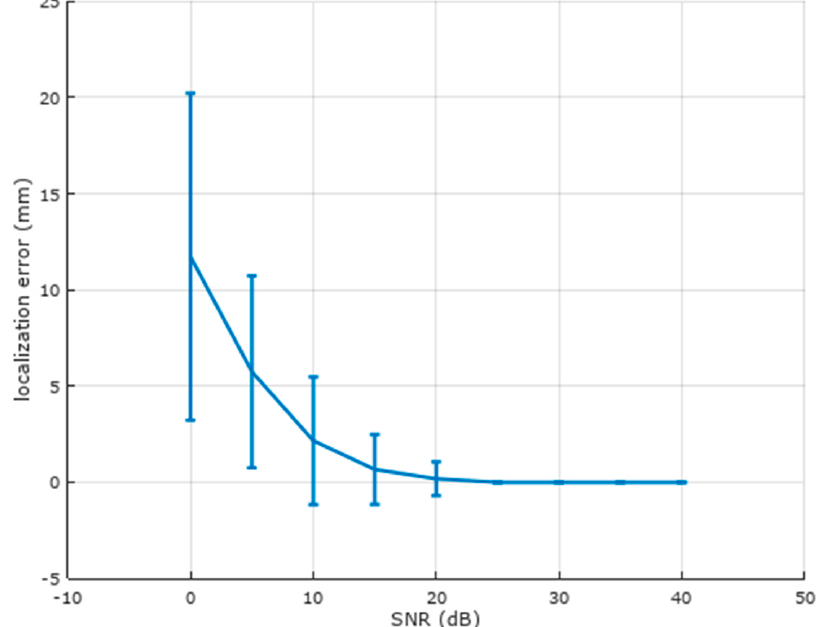
Figure 8. Localization error vs. signal-to-noise (SNR) ratio for the realistic head model. Mean and standard deviation are shown for 250 randomized trials at each SNR. Localization is much better than the spherical head model at lower SNRs.